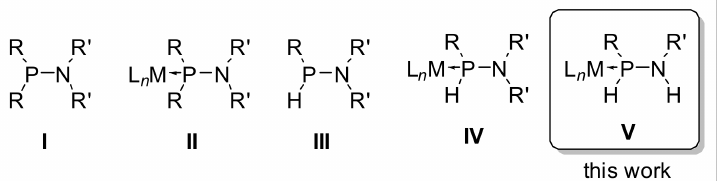
Figure 1. Aminophosphanes I , 1,1 (cid:48) -bifunctional aminophosphanes III and their complexes II and IV and 1,2-bifunctional aminophosphane complexes V (R, R’ = common organic substituent, M = transition metal, L =